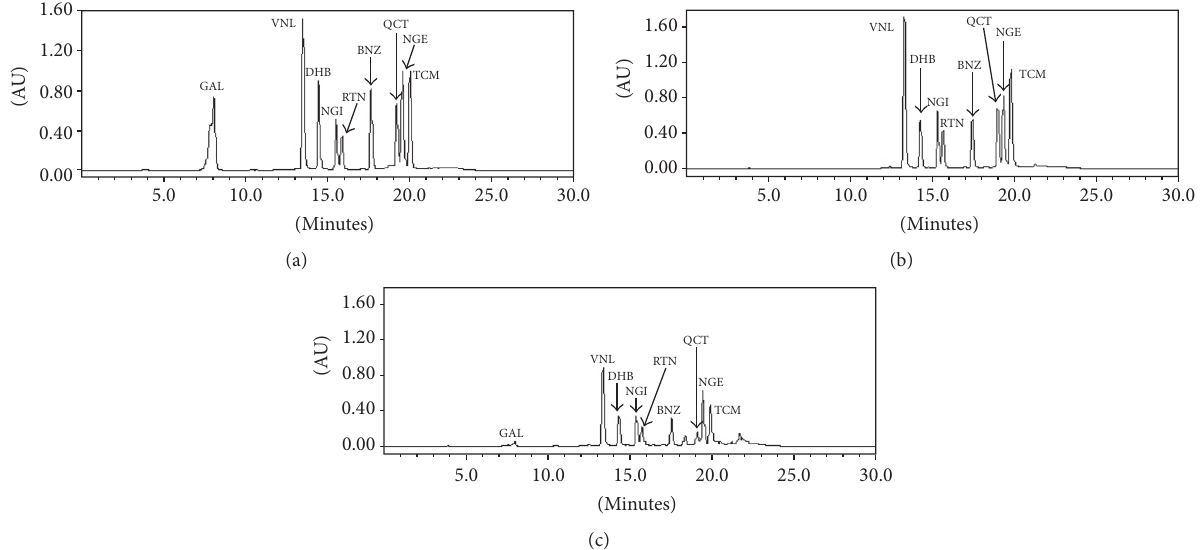
Figure 1: Chromatograms of (a) polyphenol standards, (b) polyphenols extracted using C 18 cartridges, and (c) polyphenols extracted using Amberlite XAD-2 resin. Gallic acid (GAL), benzoic acid (BNZ), dihydroxybenzoic acid (DHB), naringenin (NGE), naringin (NGI), rutin (RTN), quercetin (QCT), trans-cinnamic acid (TCM), and vanillic acid